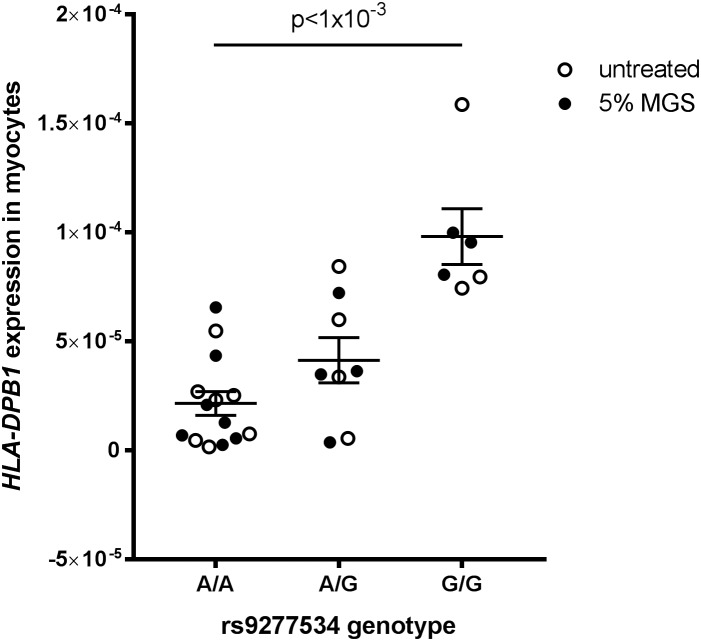
HLA-DPB1 rs9277534 is an eQTL in myocytes. Myocytes (derived from transdifferentiated dermal fibroblasts) from OP-MG (n = 10) and control MG (n = 5) individuals were either left untreated or exposed to 5% MG sera for 24 h before RNA was harvested for analysis of gene expression by quantitative PCR. HLA-DPB1 expression levels were determined using relative quantification (2−ΔCq) where ΔCq represents HLA-DPB1 Cq – RPLP0 Cq (reference gene). An ordinary one-way ANOVA was used to compare genotype groups using pooled data from 2 independent experiments (untreated myocytes and myocytes exposed to MG). Error bars show SEM. One OP-MG sample with A/A genotype was excluded as an outlier.